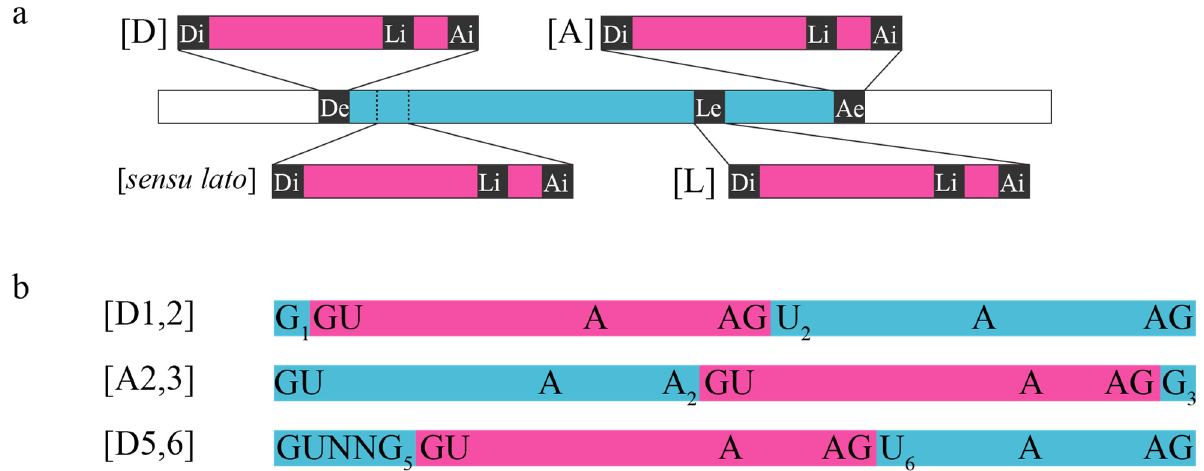
Figure 1. Stwintrons are complex intervening sequences of nested canonical U2 introns excised by consecutive standard splicing reactions. ( a ) Classes of stwintrons. Stwintrons are the spliceosomal analogues of the originally described group II/III twintrons (twin introns) in plastid genomes of Euglena gracilis . Stwintrons can occur in four classes, depending on the location where the internal U2 intron interrupts the continuity of the external U2 intron: [D], in the latter’s 5 ′ -donor; [L], in its canonical lariat branch point (BP) element; [A], in its 3 ′ -acceptor; [sensu lato], canonical intron within canonical intron, where the internal intron does not disrupt the [D], [L] or [A] elements of the external intron. The internal intron is shown in magenta, the external intron in turquoise. ( b ) Structure of the [D1,2], [A2,3] and [D5,6] types of stwintrons. The schemes show the exact site of the continuous internal intron located within the split external intron sequence: the internal U2 intron must be excised from the pre-mRNA before the external U2 intron can be spliced out and the bordering exons are properly fused [18]. When a G is the first exonic nt downstream of the most 3 ′ -splice site of a [D1,2] (5 ′ -HAG|G), the complex intervening sequence can be alternatively removed as an [A2,3] stwintron located one nt to 3 ′ , the two alternative splicing paths yielding the same continuous exonic sequences [23,24].